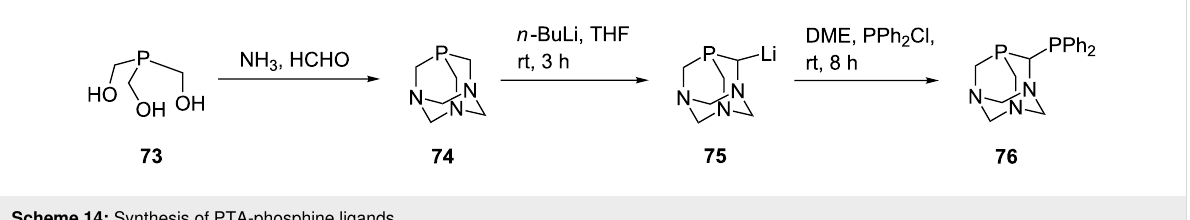
Scheme 14: Synthesis of PTA-phosphine ligands.